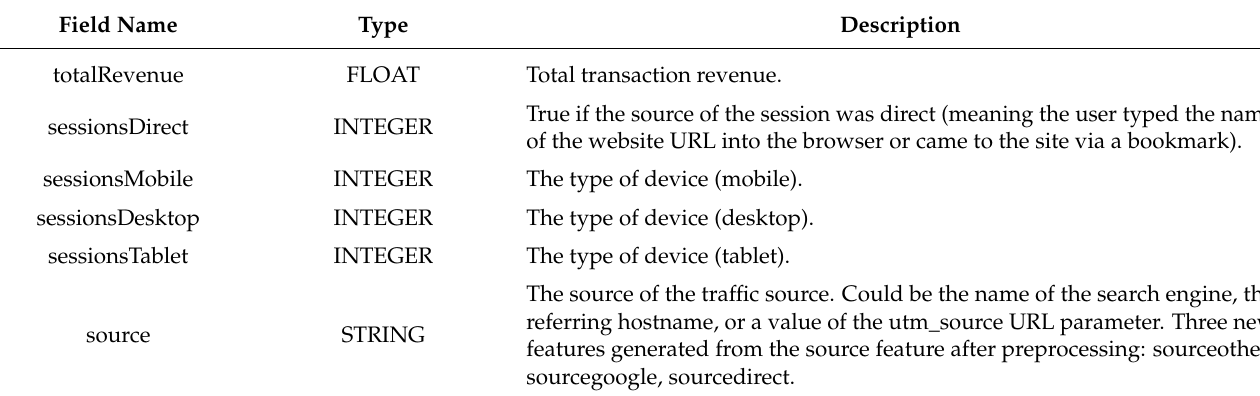
Table A1. Features extracted from the